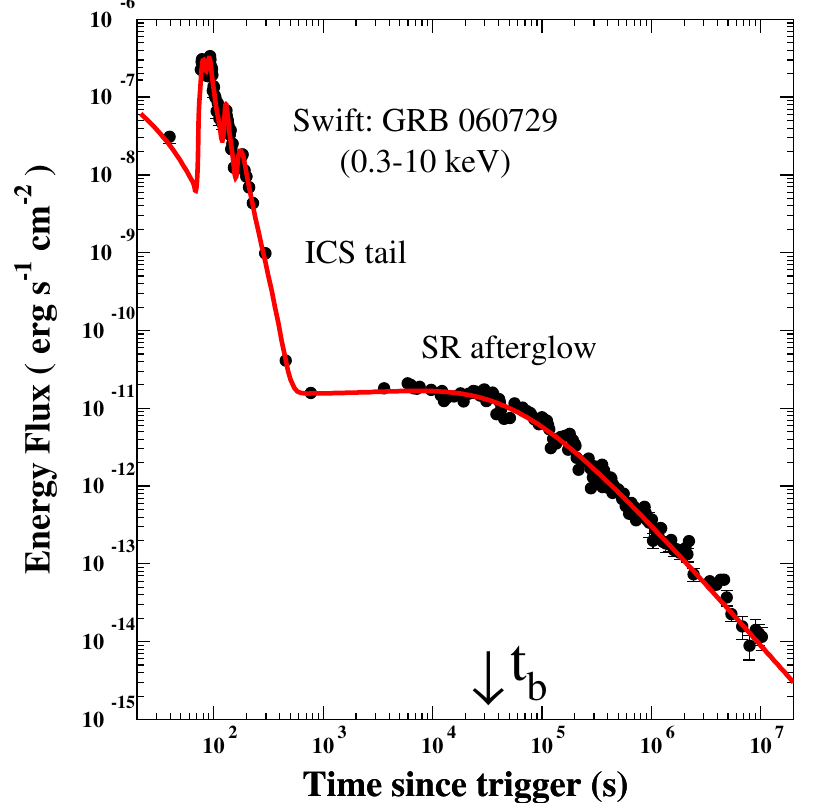
Figure 13. The canonical light curve of the X-ray AG of the SN-GRB 060729 measured with Swift XRT [95,96], and its best fit CB-model AG [12,53–57], given by Equation (8). The data also satisfy the CB model prediction α x = β x +